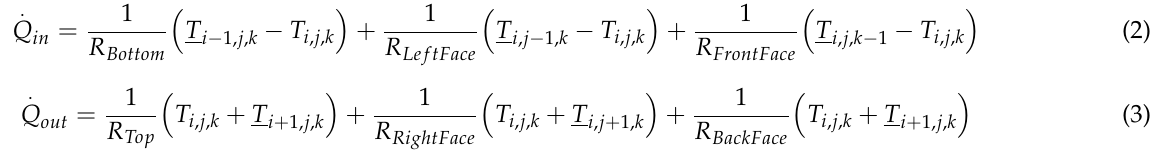
The first term of each equation represents the energy transfer in the radial direction. The second represents the energy transfer in the circumferential direction, and the third If a node is contained entirely within the near field and is bounded neither by the far represents the energy transfer in the axial direction. The resistors (each of which is written field nor by the pipe wall, its energy balance is made up of purely conductive terms. The in the form ( ∆ x/kA) equations for 𝑄(cid:4662) (cid:3036)(cid:3041) and 𝑄(cid:4662) (cid:3042)(cid:3048)(cid:3047) are: